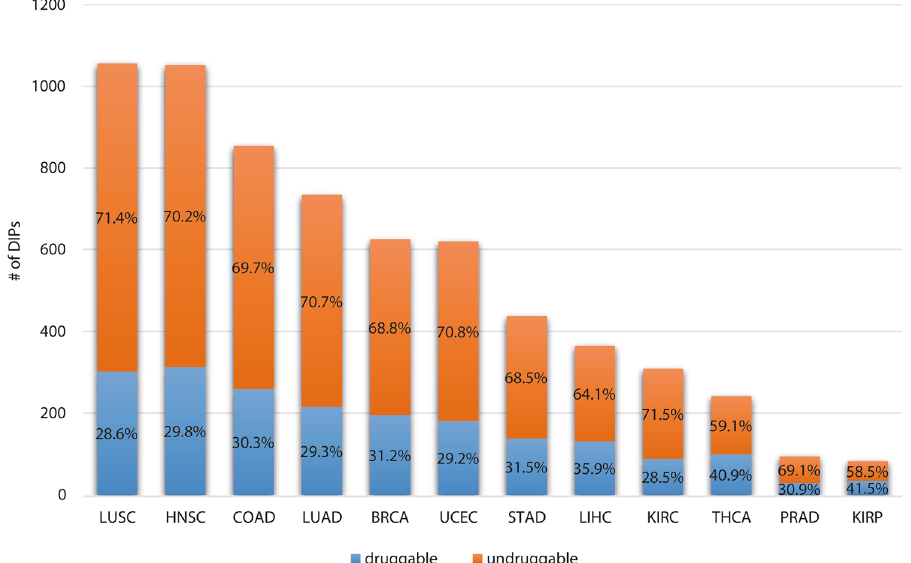
Figure 8. Classification of DIPs. The stacked bar graph indicates the number of DIPs, which are druggable (blue bars) and undruggable (orange bars) and their percentage for each